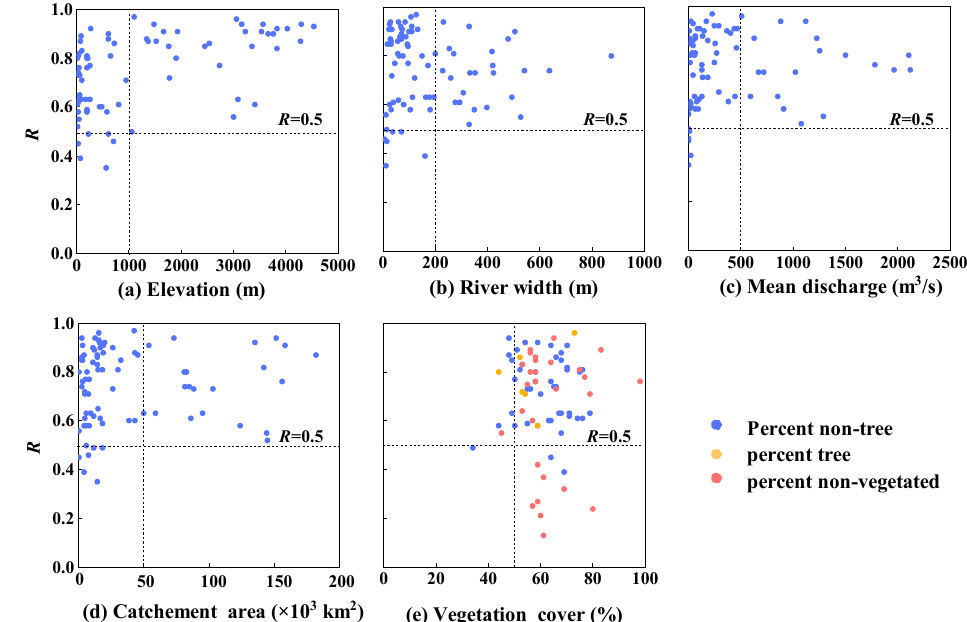
Figure 10. Relationship between R and the influencing factors including ( a ) elevation, ( b ) river width, ( c ) mean discharge, ( d ) catchment area and ( e ) vegetation cover for the 79 stations. River width: According to the equation Q = v · A , the variation of runoff Q depends not only on the runoff velocity v , but also the river cross-sectional area A , which is related to the river width, water depth and cross-sectional geometry. As a result, there can exist a relationship between R score and river width W [63]. As shown in Figure 10b, all stations with W ≥ 200 m have an R score greater than 0.5; 90.9% of the 55 stations with W < 200 m are greater than 0.5, while the stations showing inferior results are primarily those with river widths of less than 100